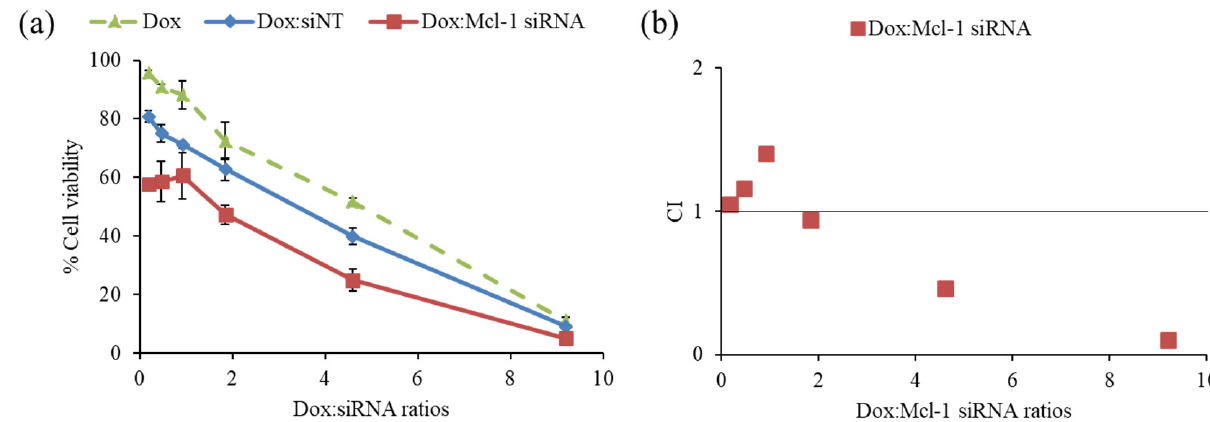
Figure 5. Screening synergistic effect of doxorubicin (Dox) and Mcl-1 siRNA combination at ratios of 0.2, 0.5, 0.9, 1.8, 4.6, and 9.2, ( a ) cell viability of non-constant ratio experiment and ( b ) CI-combination ratio plot. The concentration of each agent in every data point was described in the materials and methods section.